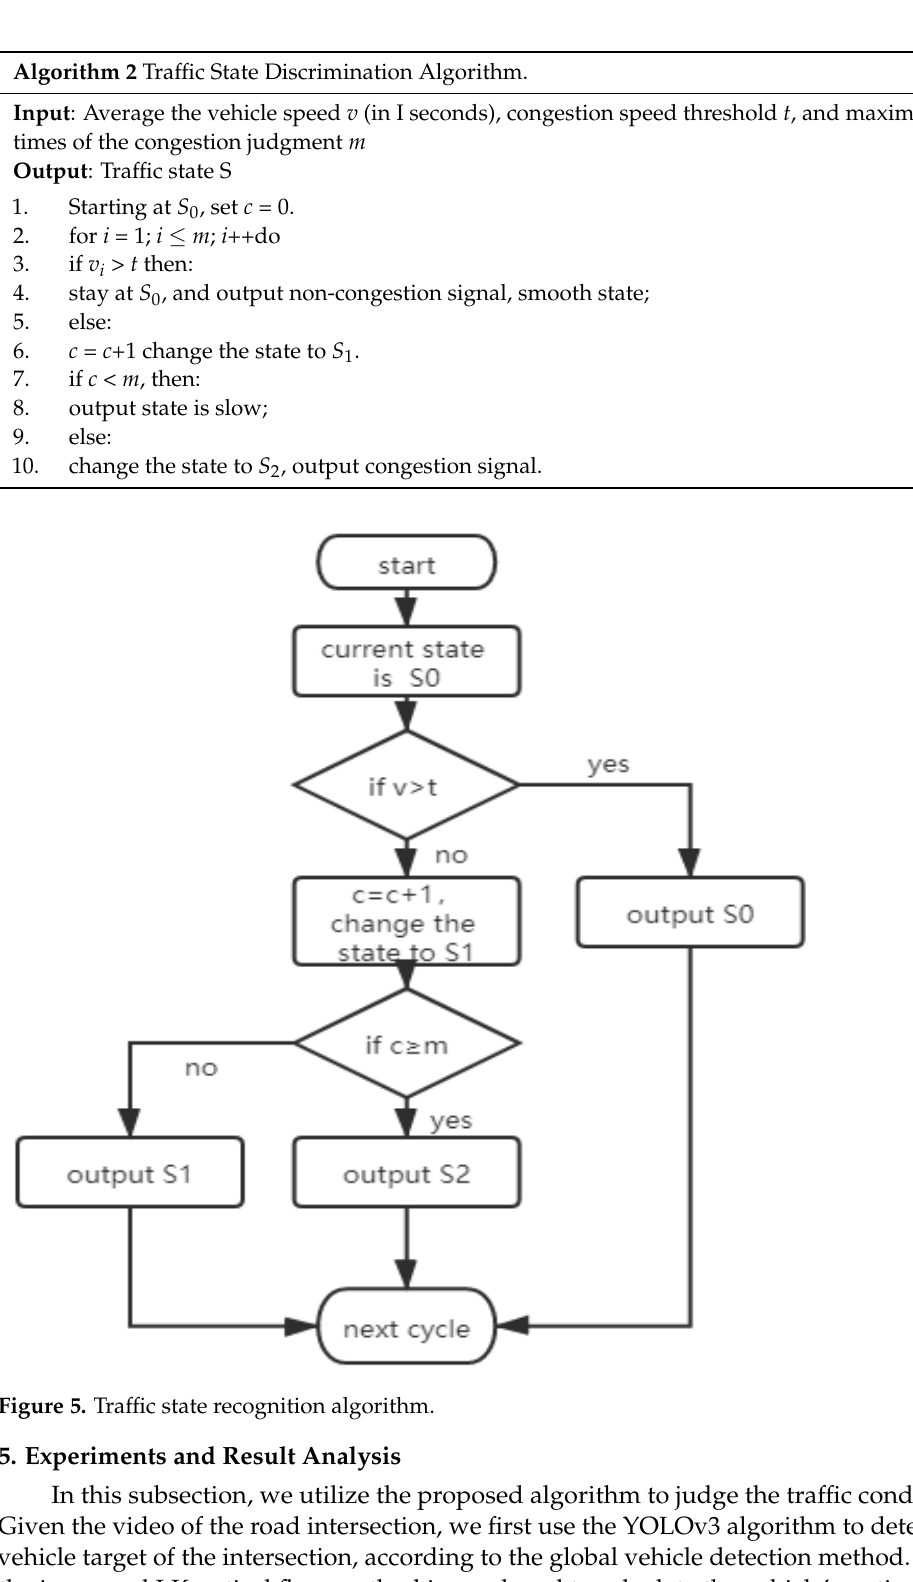
Algorithm 2 Traffic State Discrimination Algorithm.